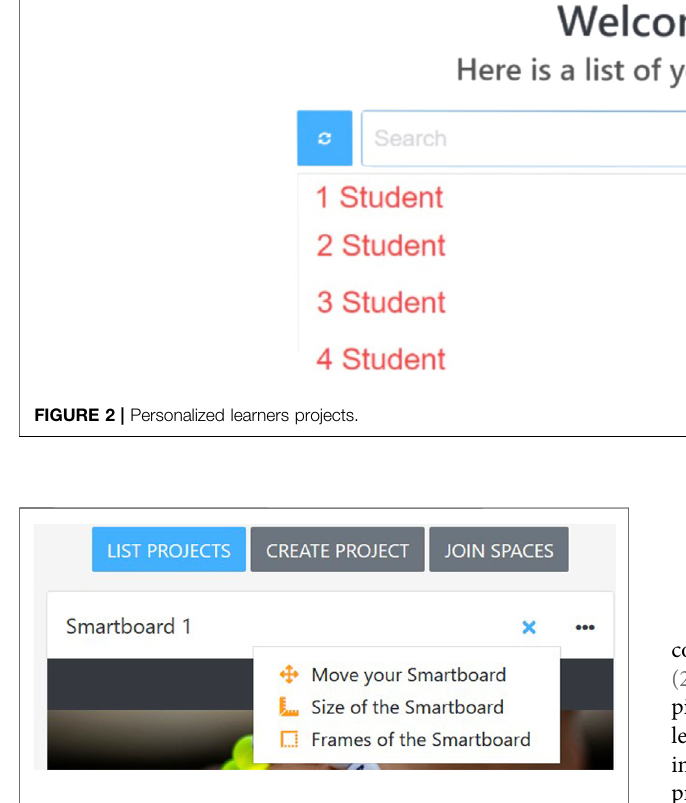
FIGURE 3 | Personalizing